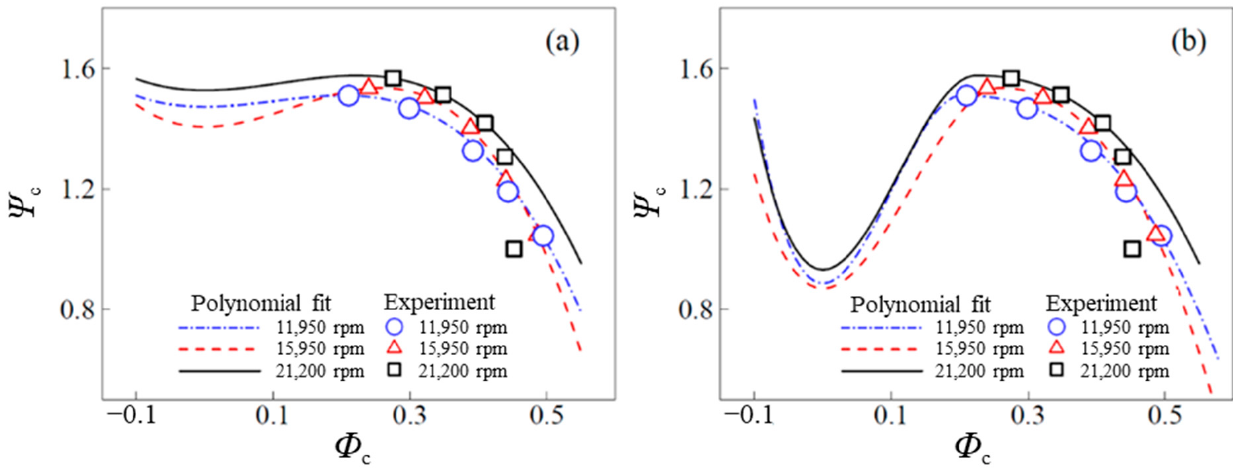
Figure 6. Approximated compressor characteristic curve: ( a ) fitted with experimental data and ( b ) adjusted valley point.